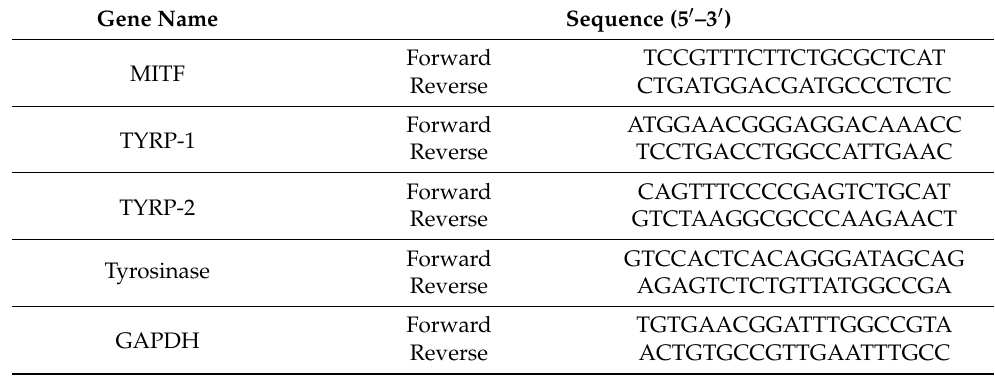
Table 2. Primer sequences for quantitative real-time PCR